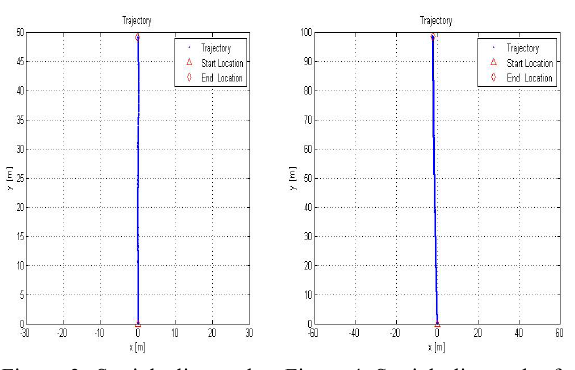
Figure 4. Straight line path of 100 meters